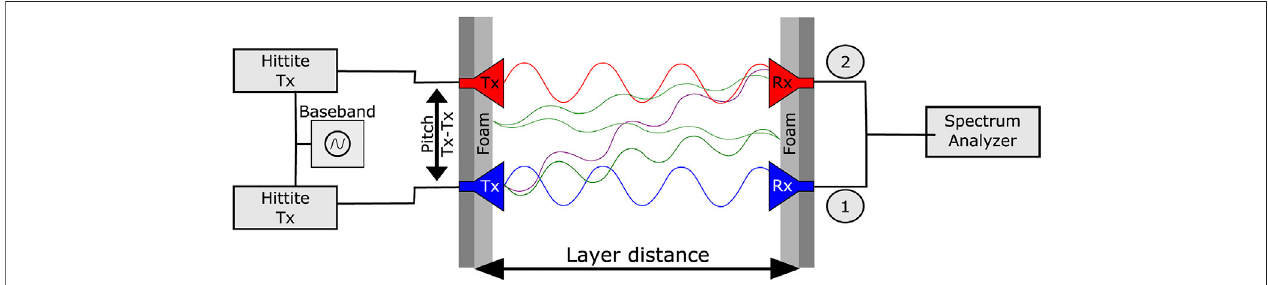
FIGURE 6 | Sketch of the setup to measure crosstalk with two links between highly re fl ective aluminium layers. LOS crosstalk is indicated as purple wave [26].